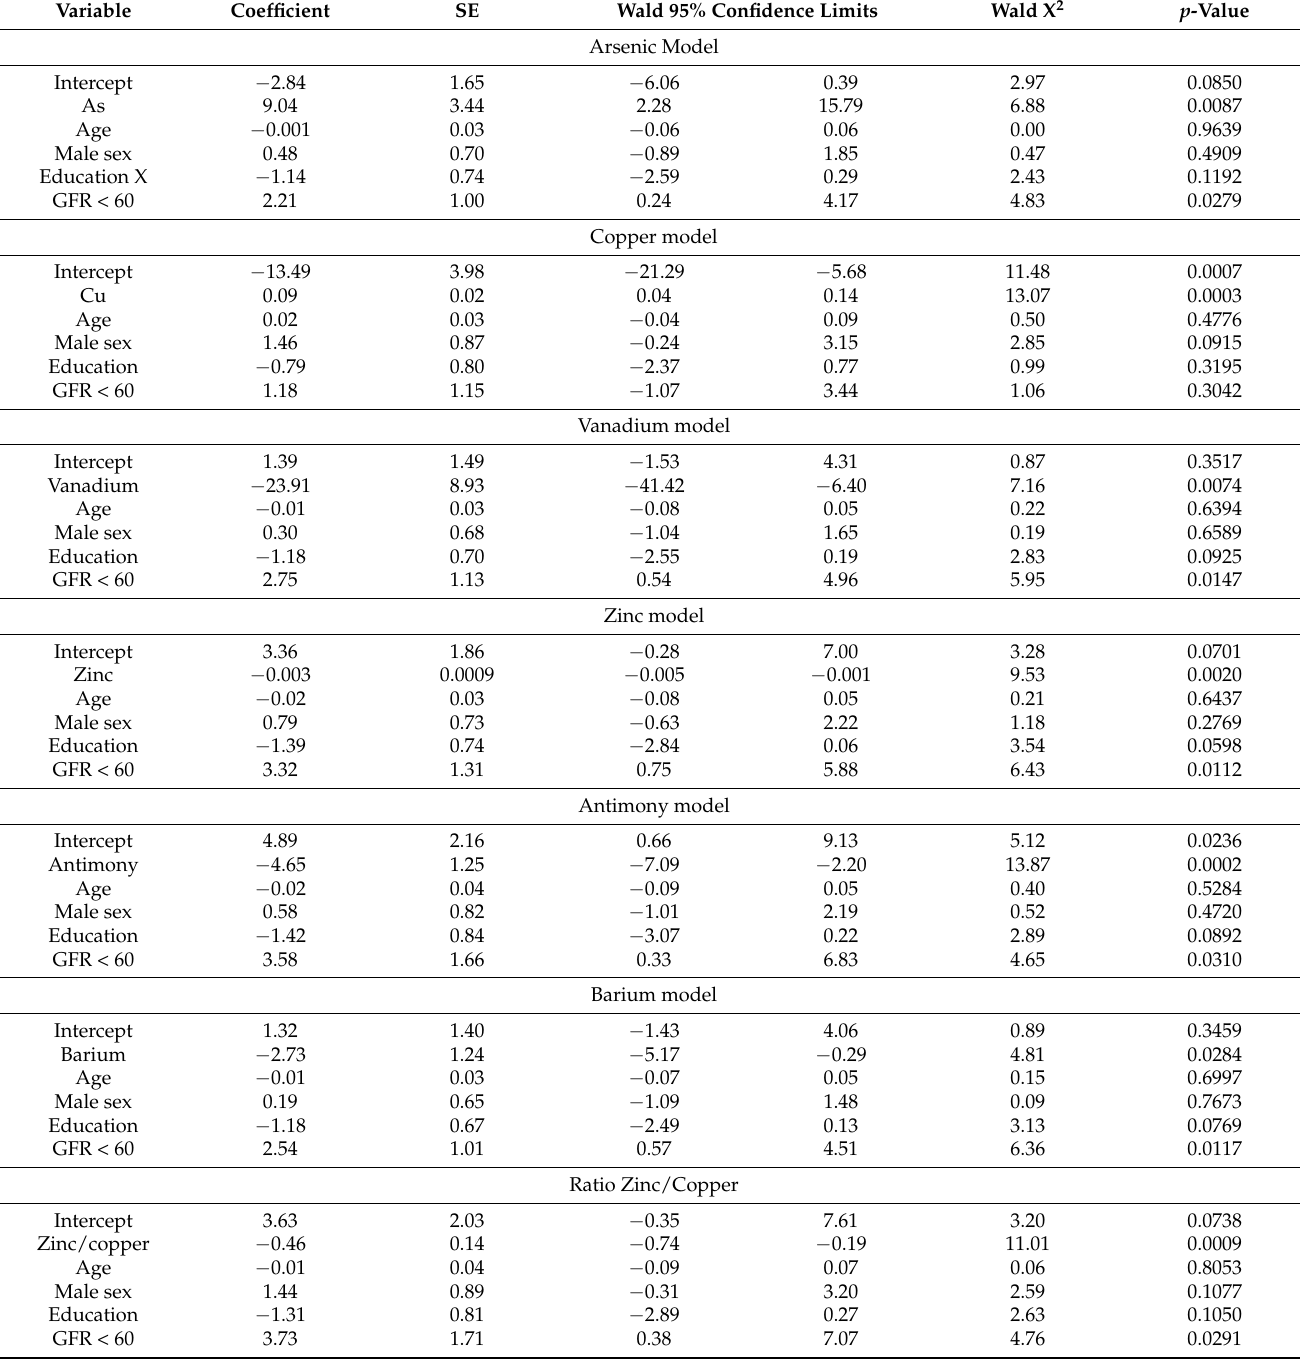
Table 2. Adjusted models of DCM as a function of blood metal